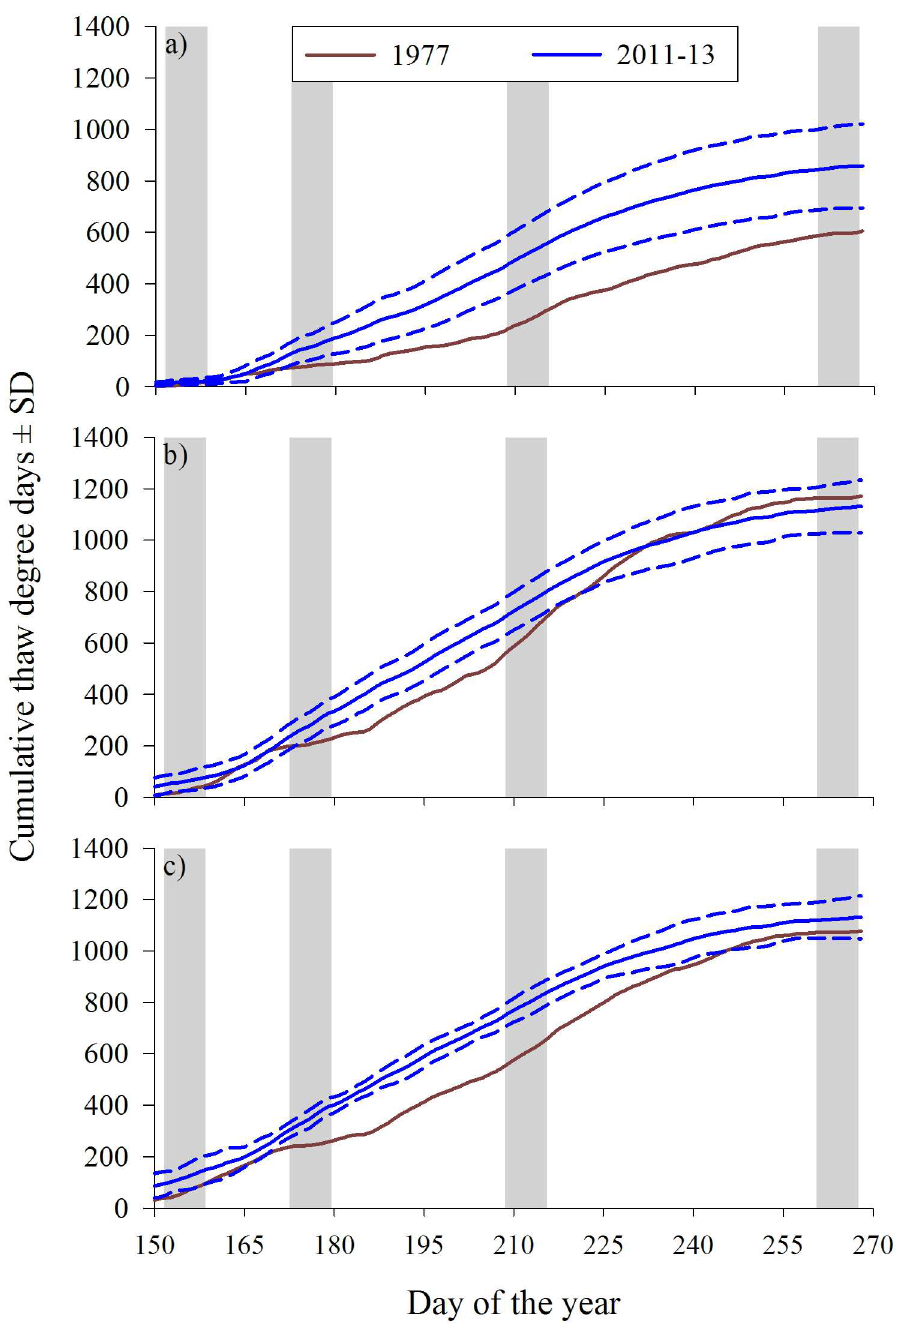
Fig 3. Growing conditions, as indexed by cumulative thaw degree days, throughout the growing seasons of 1977 and 2011–13when caribou forages were collected within the a) Coastal Plain, b) Foothills, and the c) Brooks Range ecoregions on the North Slope of the Brooks Range in the Alaskan Arctic. Shading denotes the periodsof interest (days of year): peak parturition(152–158), peak lactation (173–179), peak forage biomass (209–215), and senescence